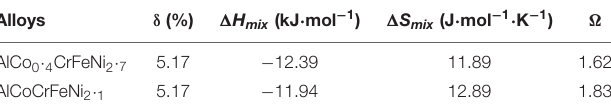
TABLE 2 | (cid:49) H mix , δ , (cid:49) S mix , and (cid:127) of the AlCo x CrFeNi 3 . 1 − x alloys.